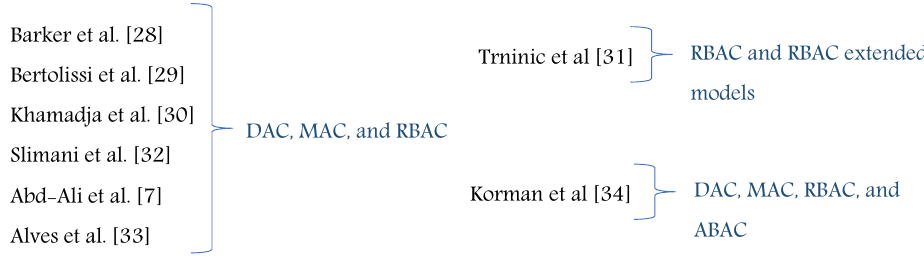
Figure 13. The components that the proposed metamodels